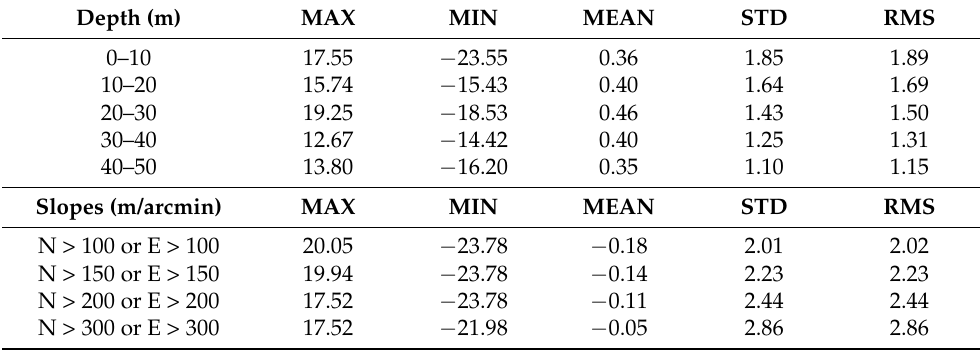
Table 11. Differences between SCSGA V1.2 and SCSGA V1.0 in different areas (in mGal).